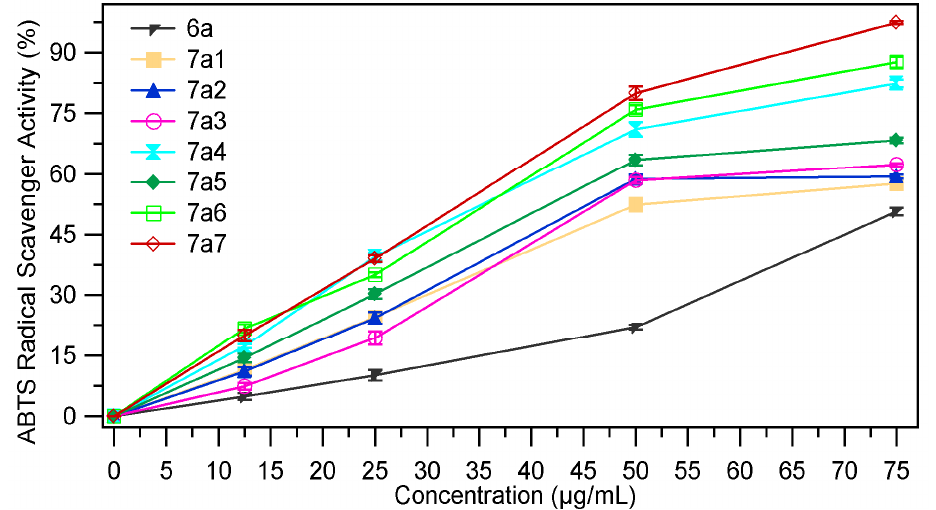
in ref. with 6a . 1–7